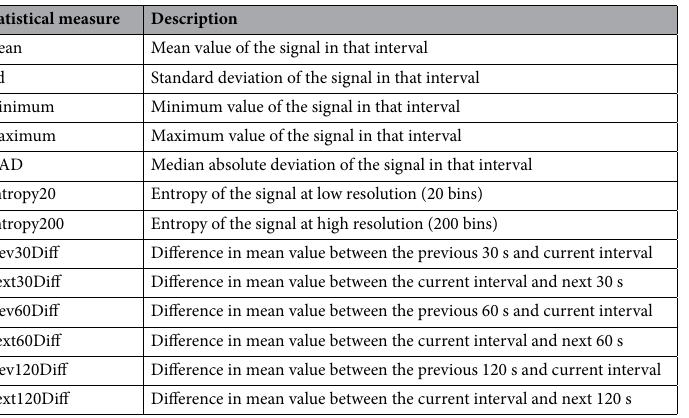
Table 4. Statistical measures applied to derived